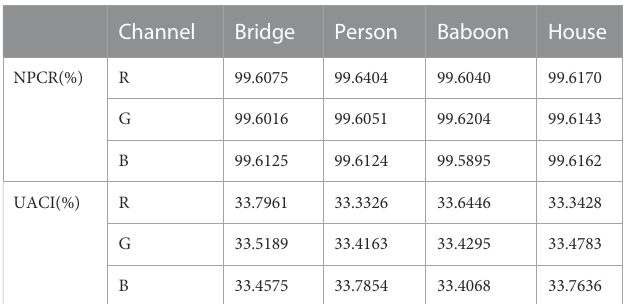
TABLE 4 Image correlation. TABLE 5 Value of NPCR and